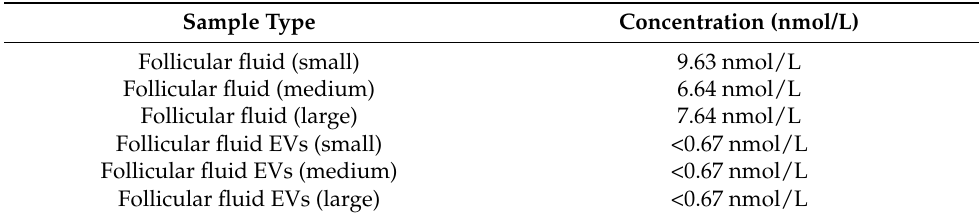
Table 1. The concentration of progesterone in FF and FF-derived EV